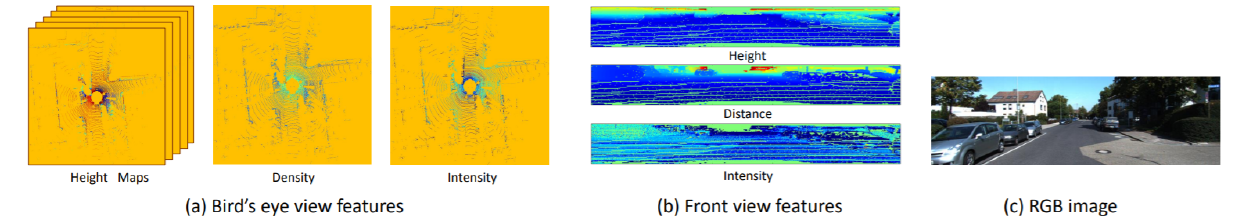
Figure 20. The input features of the MV3D [73]